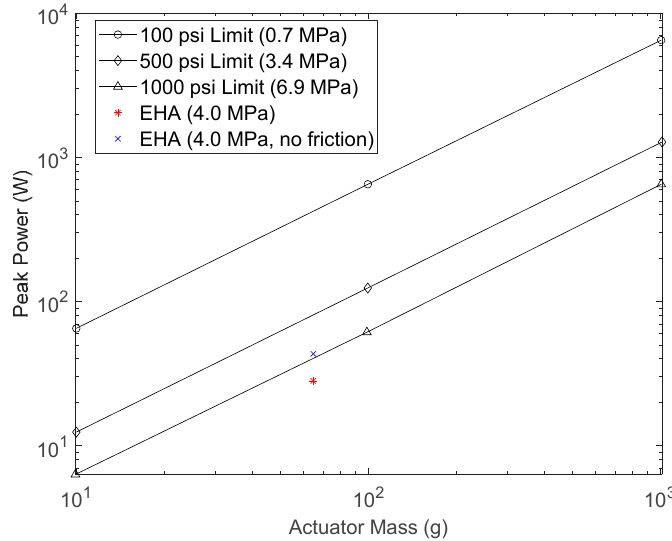
Figure 13. EHA specific performance compared to limits from [25]. This also includes a point for the ideal case of the EHA system with no friction, which is near the limit. Table 7. Estimated system cost for a Valve B